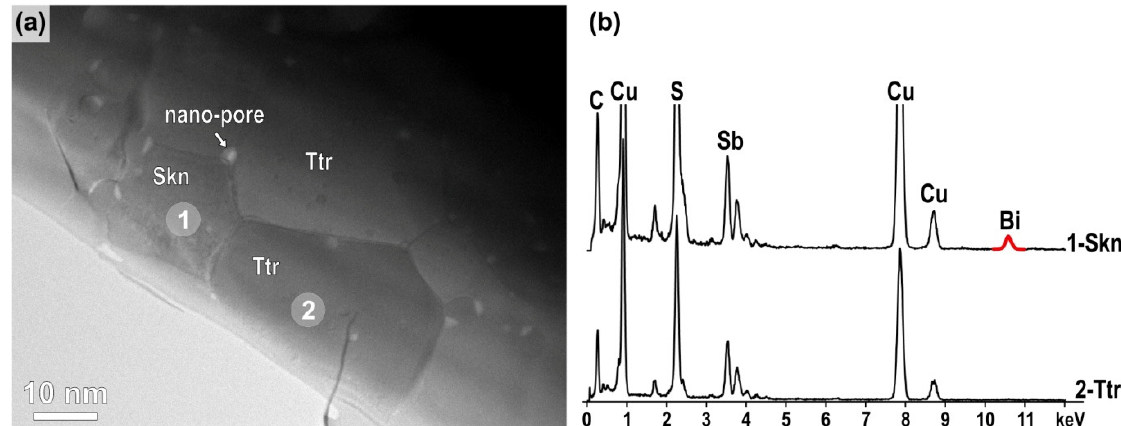
Figure 6. ( a ) TEM image and ( b ) EDS analysis of the X Bi = 0.2 sample show that Bi is preferentially incorporated into skinnerite.